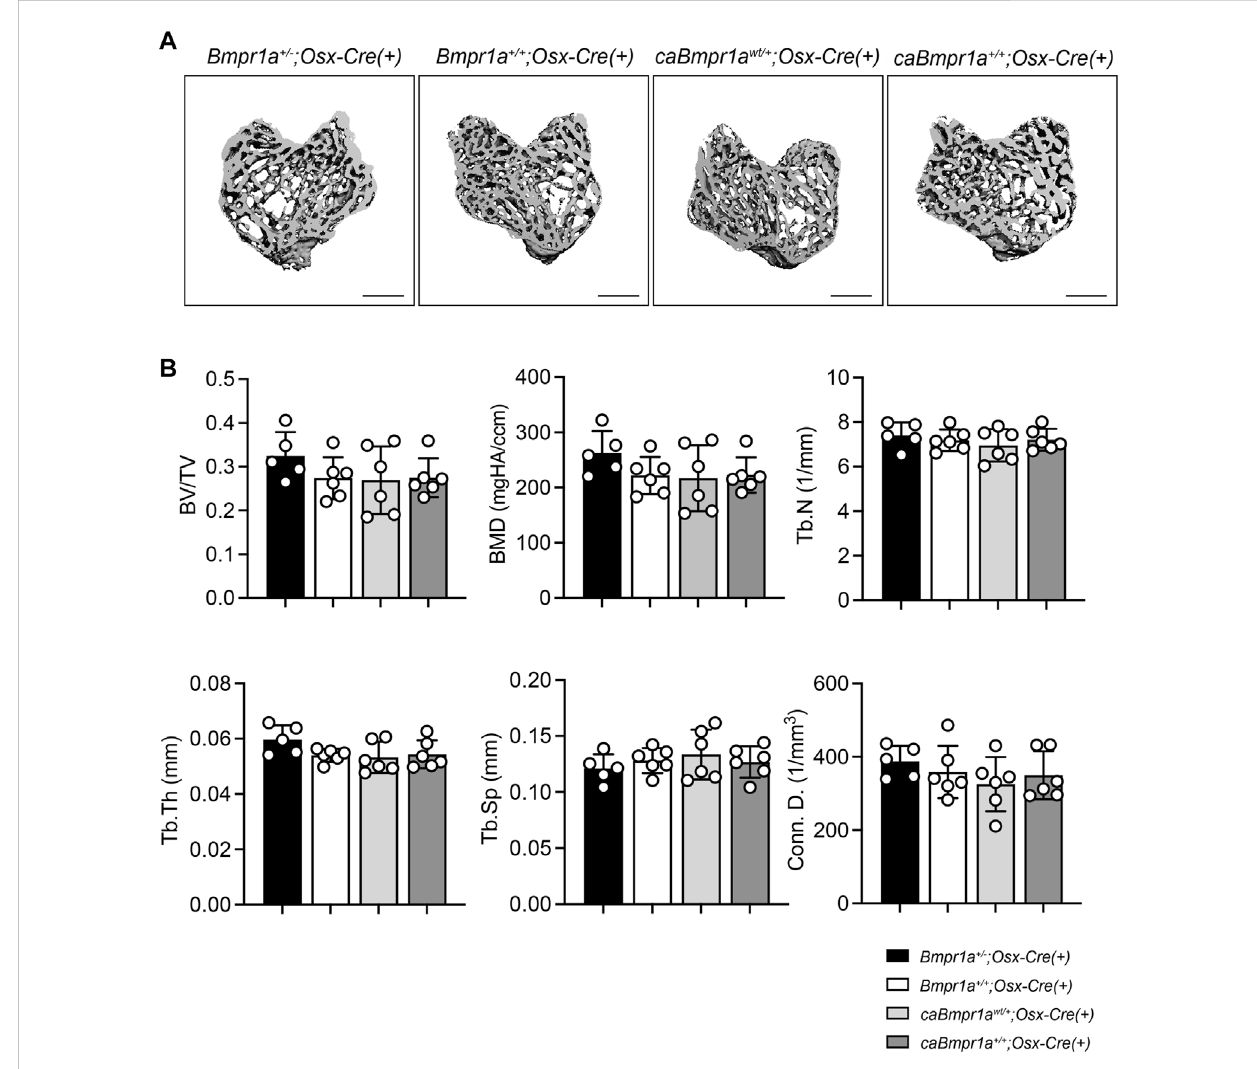
FIGURE 2 Micro-CT analysis for trabecular compartments of the male mouse tibia at 12 weeks of age. (A) Micro-CT based 3D images of the mouse proximal tibia.Scalebar=500 µm. (B) Bone volume(BV/TV),bonemineral density (BMD),trabecularnumber(Tb.N),trabecularthickness(Tb.Th),trabecular space (Tb.Sp) and connective density (Conn.D.) were analyzed (n = 5 male for Bmpr1a +/ − ;Osx-Cre mice, n = 6 male for Bmpr1a +/+ ;Osx-Cre, caBmpr1a wt/+ ;Osx- Cre, caBmpr1a +/+ ;Osx-Cre